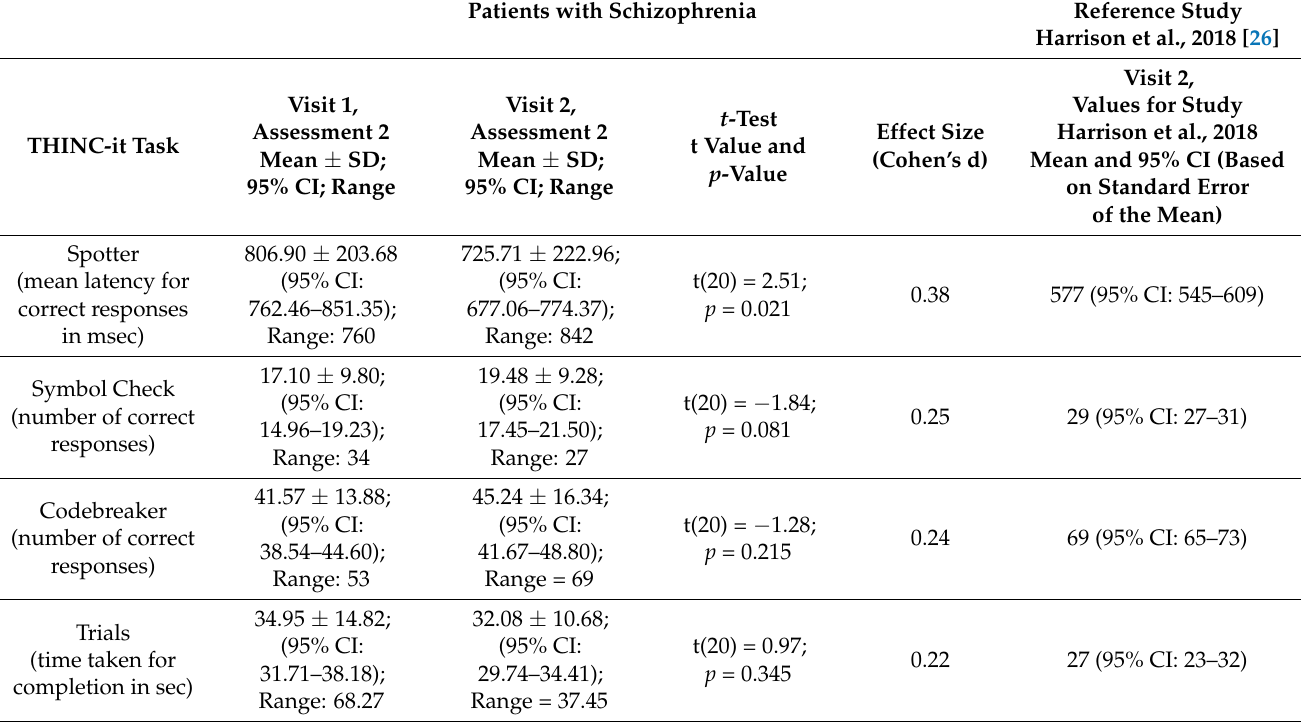
Table 1. Descriptive statistics and 95% Confidence Interval based on Standard Error of the mean for THINC-it cognitive measures, along with corresponding paired t -Test comparisons. Data for patients with schizophrenia participating in the current study ( n = 21), as well as for healthy controls from a separate study by Harrison et al., 2018 [26]. Patients with Schizophrenia